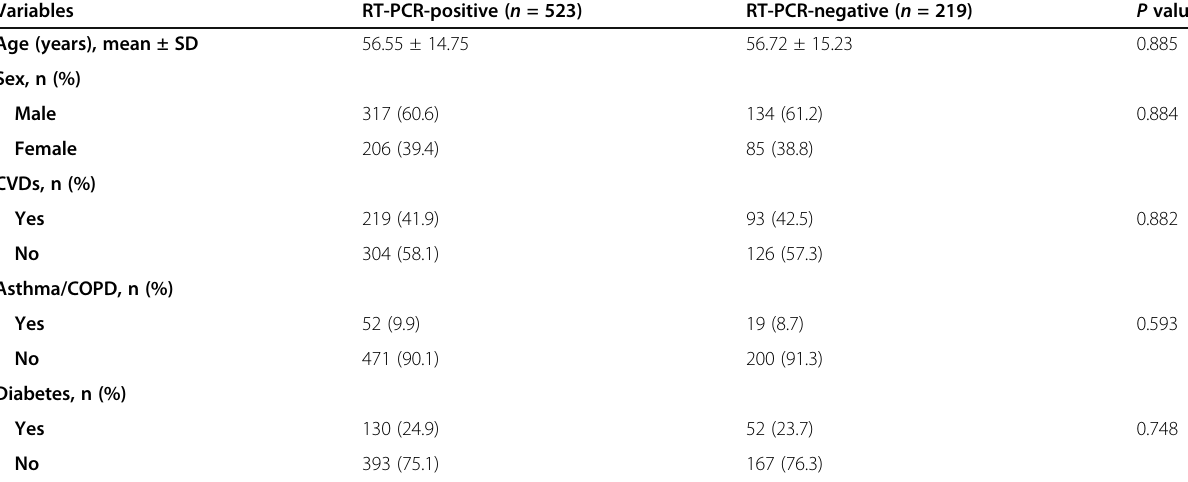
Table 1 Distribution of baseline information by real-time polymerase chain reaction (RT-PCR) results